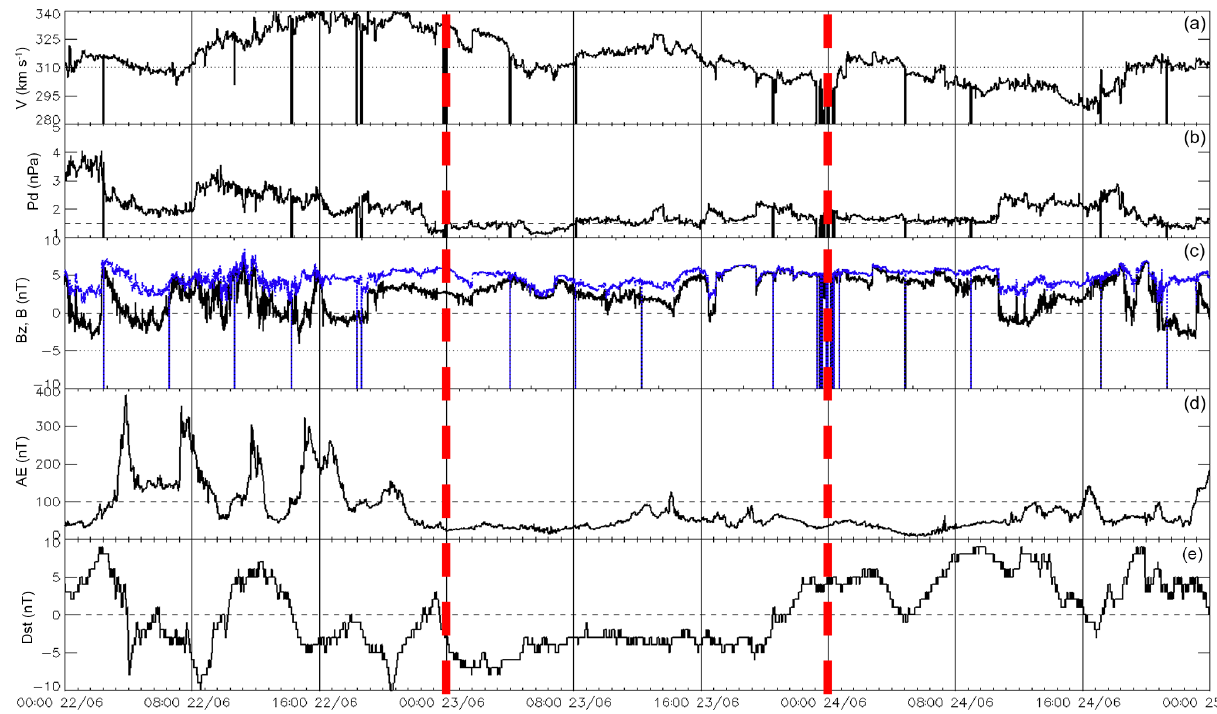
Figure 1. Solar wind and geomagnetic conditions from 22 to 24 June 2006: solar wind bulk velocity V (a) , solar wind dynamic pressure P d (b) , interplanetary magnetic field magnitude B (blue dotted curve) and Bz component (black solid curve) (c) , auroral electrojet index AE (d) , and storm-time Dst index (e) . The 23 June (indicated by vertical red dashed lines) was very quite with respect to the solar wind and geomagnetic